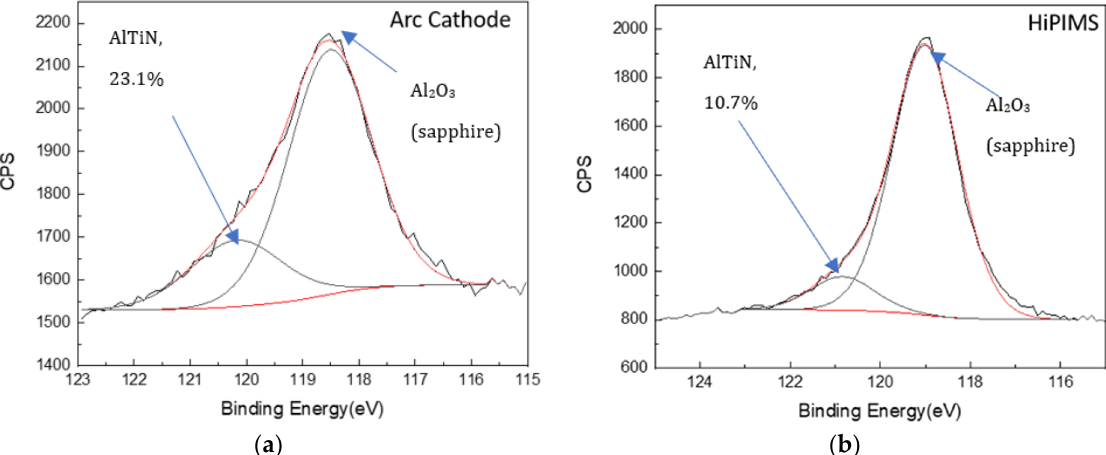
Figure 10. XPS data on the tribo-films formation on the friction surface of the cutting tool with: ( a ) CAD; ( b ) HiPIMS AlTiN coating.